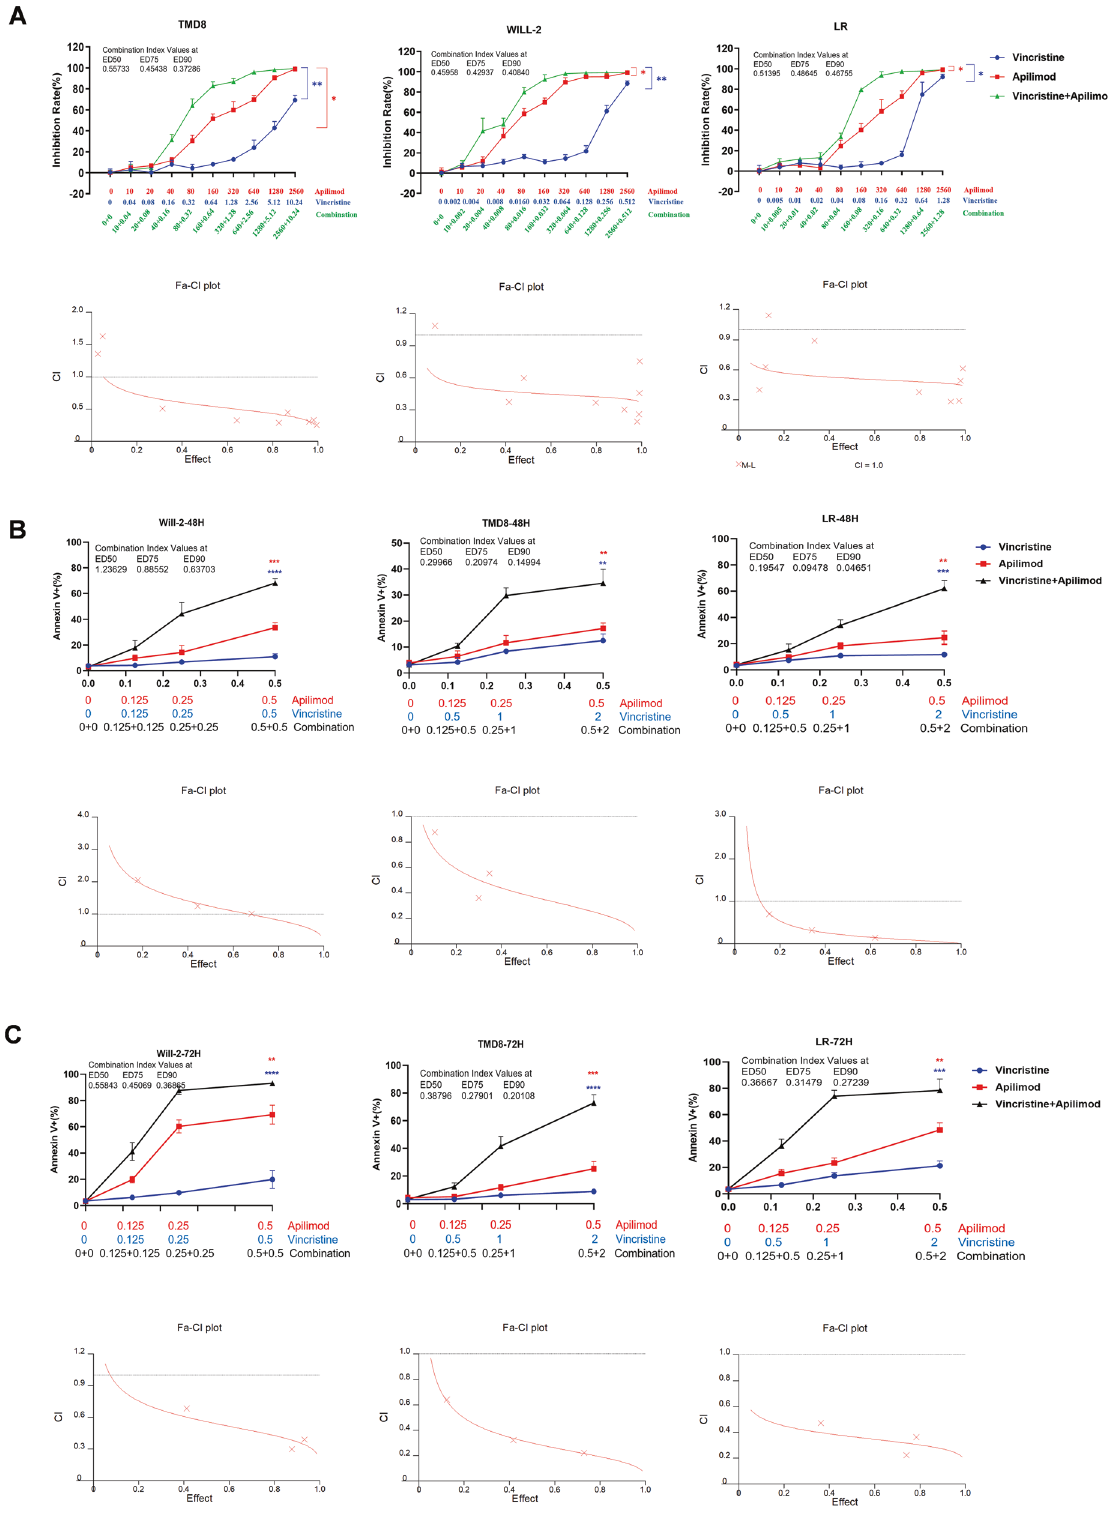
Fig. 7 PIKfyve-speci fi c inhibitor (apilimod) combined with tubulin-speci fi c inhibitor (vincristine) exerts drastic synergistic cytotoxicity toward DHL cells. Anti-proliferative effect ( A ) and apoptotic cells ( B , C ) were determined after LR, WILL-2, and TMD8 cells treated with indicated concentrations of PIKfyve-speci fi c inhibitor apilimod and tubulin-speci fi c inhibitor vincristine for 72 h or 48 h. Combination index plot were also shown based on the inhibition rates or Annexin V-positive cells. CI < 1 was de fi ned as synergism. Values indicate mean ± S.D. for at least three independent experiments performed in triplicate. * P < 0.05, ** P < 0.01, *** P < 0.001, **** P < 0.0001.